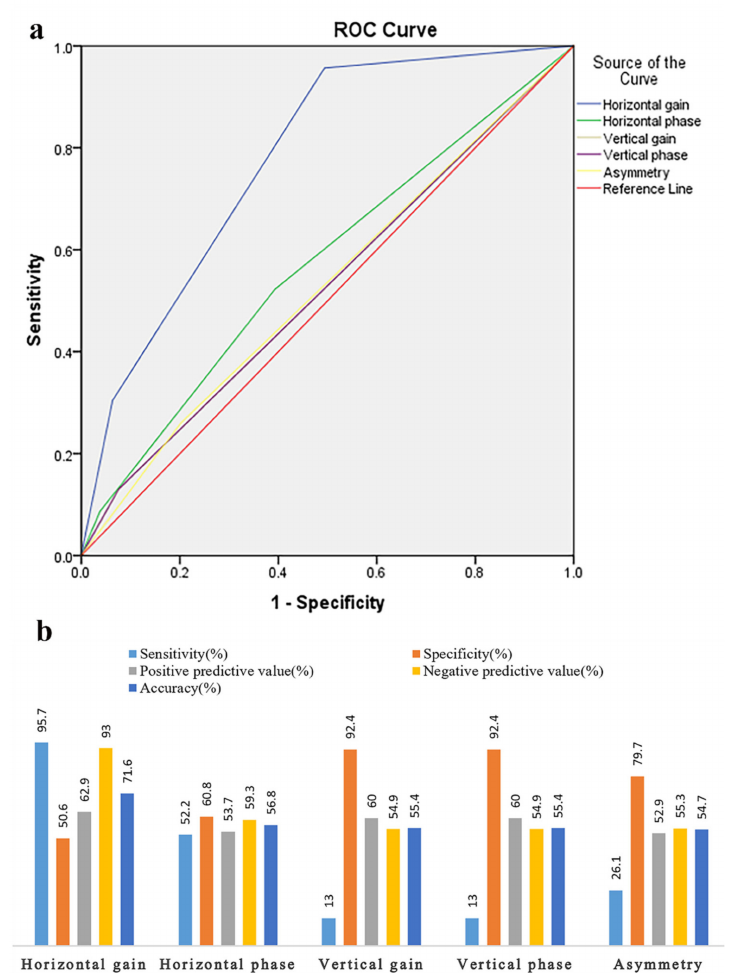
Figure 1. ROC curves of VAT in the study. ( a ) ROC curve analysis of different VAT parameters in the differential diagnosis of between MD and VM patients. Light blue line, horizontal gain; green line, horizontal phase; yellow line, vertical; purple line, vertical phase; red line, reference line. ( b ) The value of different VAT parameters in the differential diagnosis between MD and VM patients. MD, Meni è re’s disease; VM, vestibular migraine; VAT, vestibular autorotation